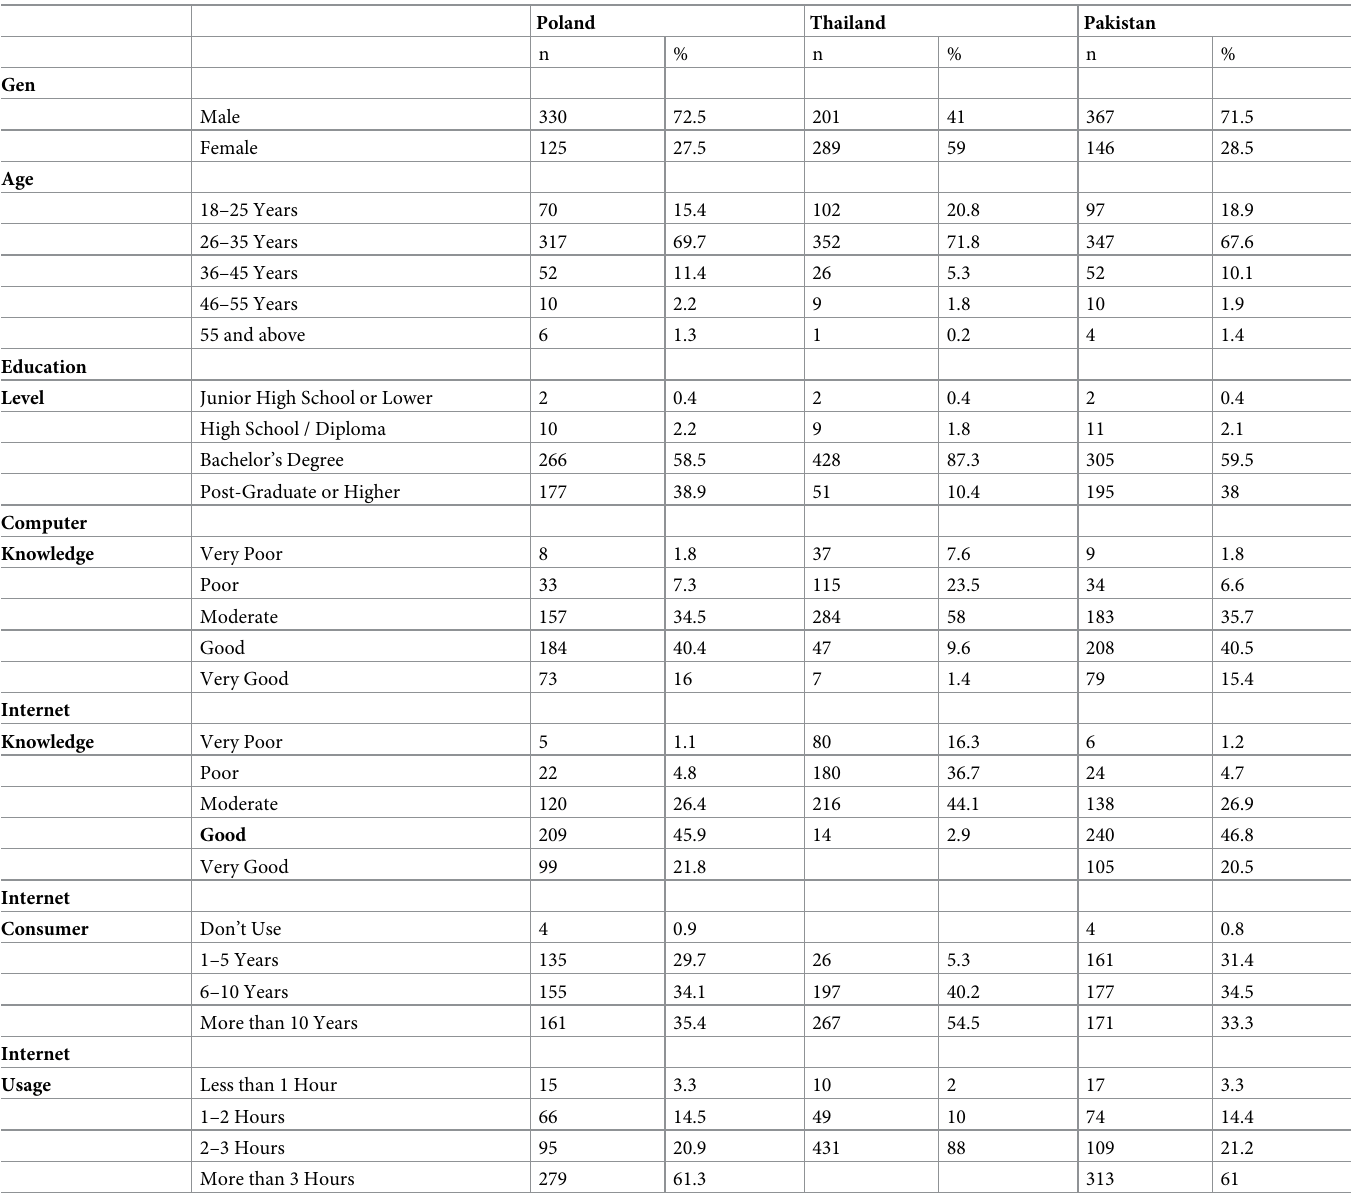
Table 2. Descriptive statistics of the